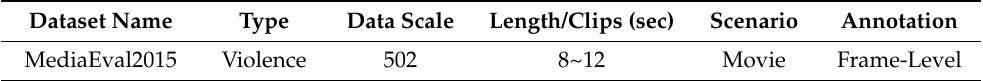
Table 1. Experimental dataset.